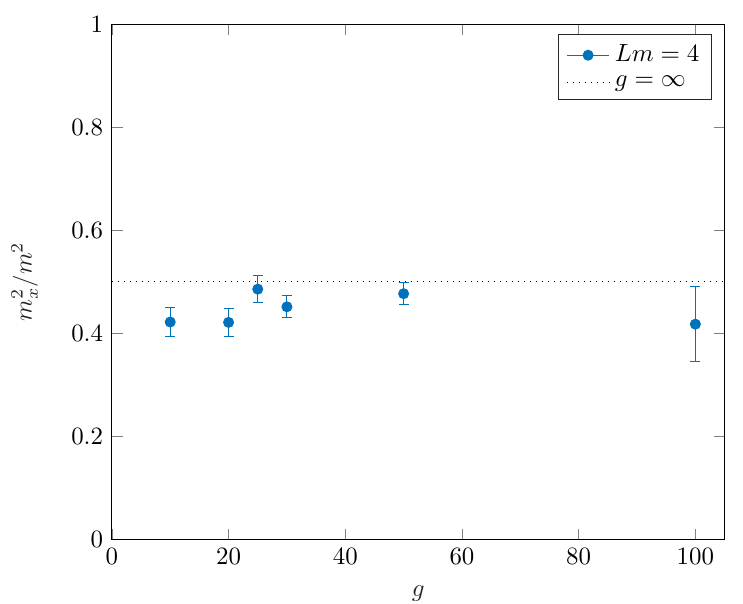
Figure 4 . Continuum values for the measured x mass versus g (blue dots). The extrapolation of the values at (cid:12)nite lattice spacing to the continuum limit is performed as in [12]. The dotted line is the g limit of the continuum ! 1